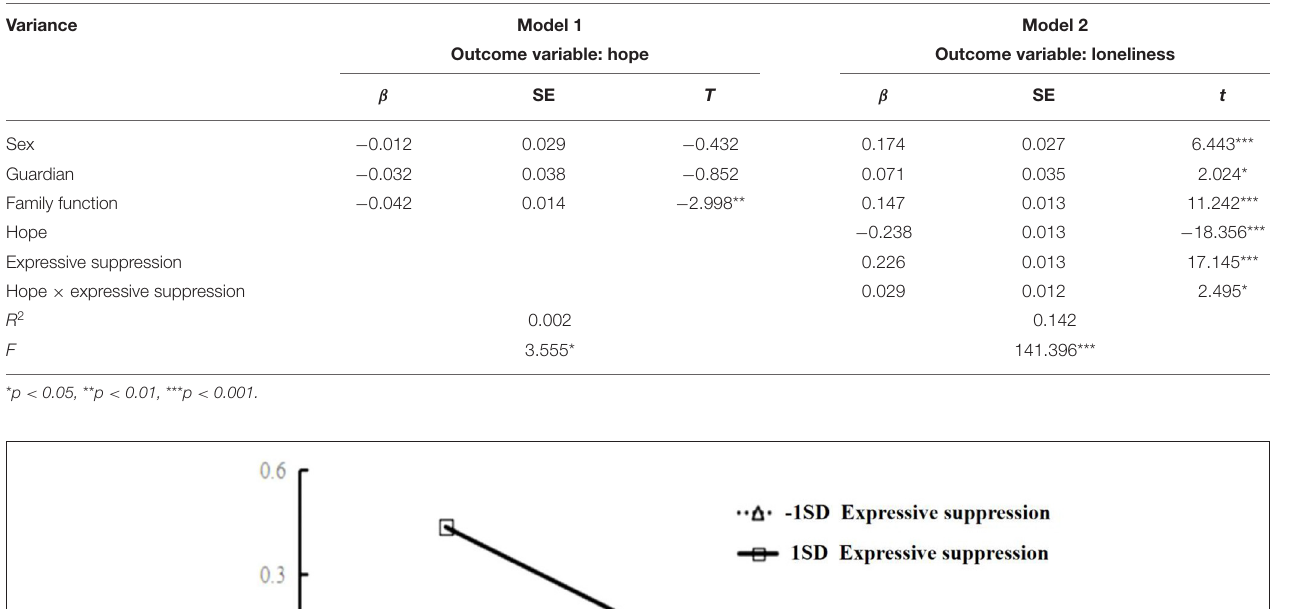
TABLE 4 | Results of the moderated mediation model analysis.